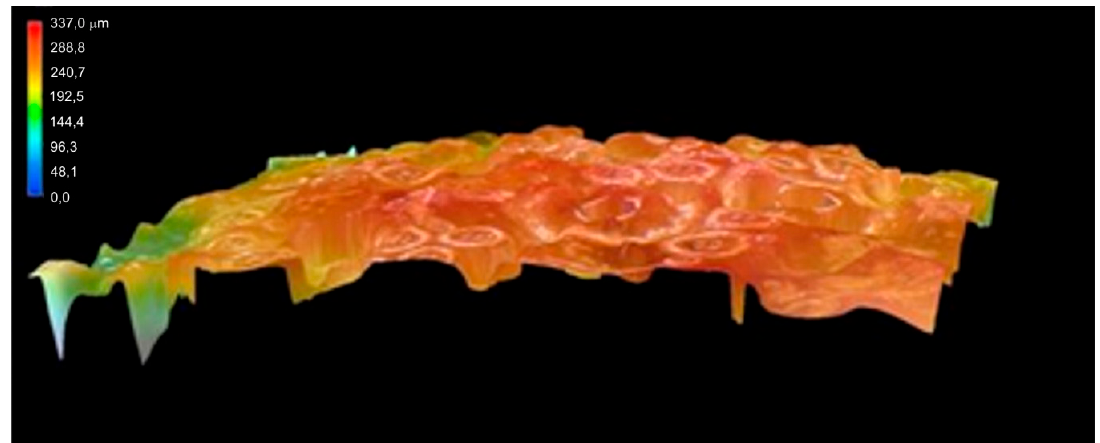
Figure 5. The particles of ground bark scattered in the adhesive mixture.